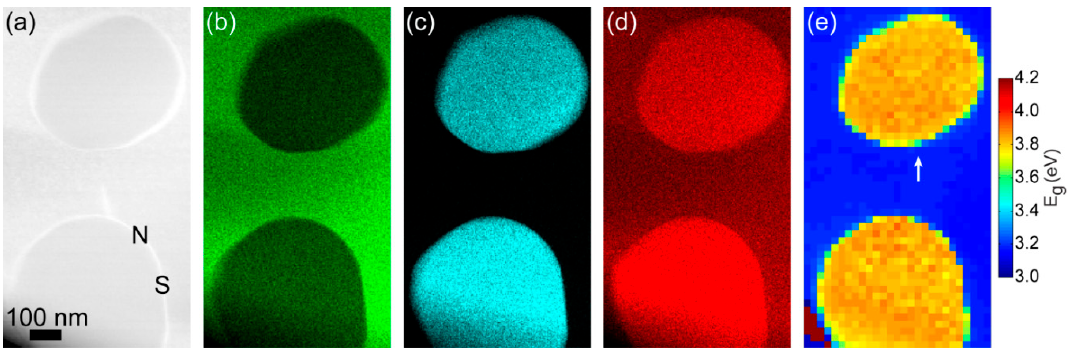
Figure 1. XRD of Cr2O3-alloyed ZnO with nano ZnCr 2 O 4 inclusion. The Si-peaks were used to calibrate the diffractogram.